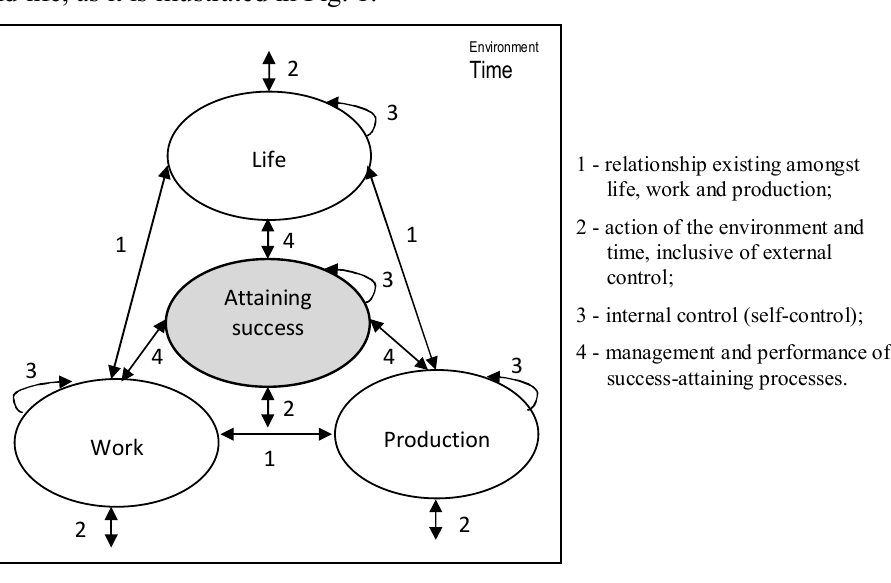
Figure 1 - To the issue of attaining sustained prosperity of individuals and